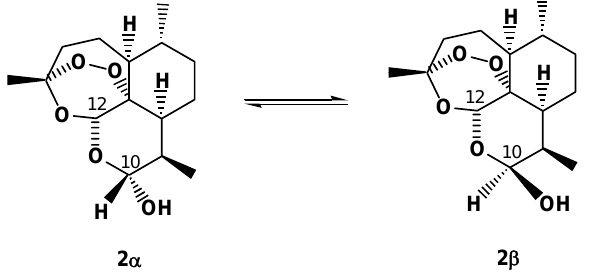
Figure 2. Chemical structures of the two interconverting epimers of DHA ( 2 ): the 2 α - epimer bears the hydroxyl group in the equatorial position (absolute stereochemistry at C- 10: R ), whereas the 2 β -epimer possesses an axial hydroxyl group.